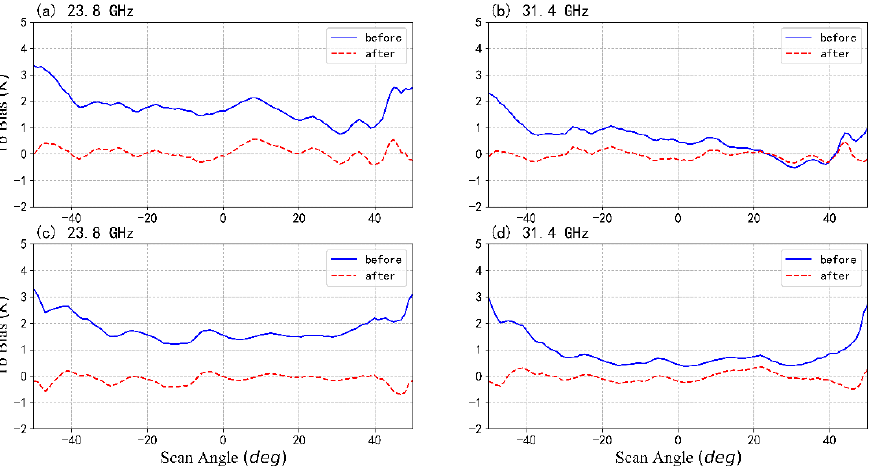
Figure 4. ATMS T b bias before and after correction for asymmetry of different channel frequencies at ( a , b ) ascending; ( c , d ) descending.